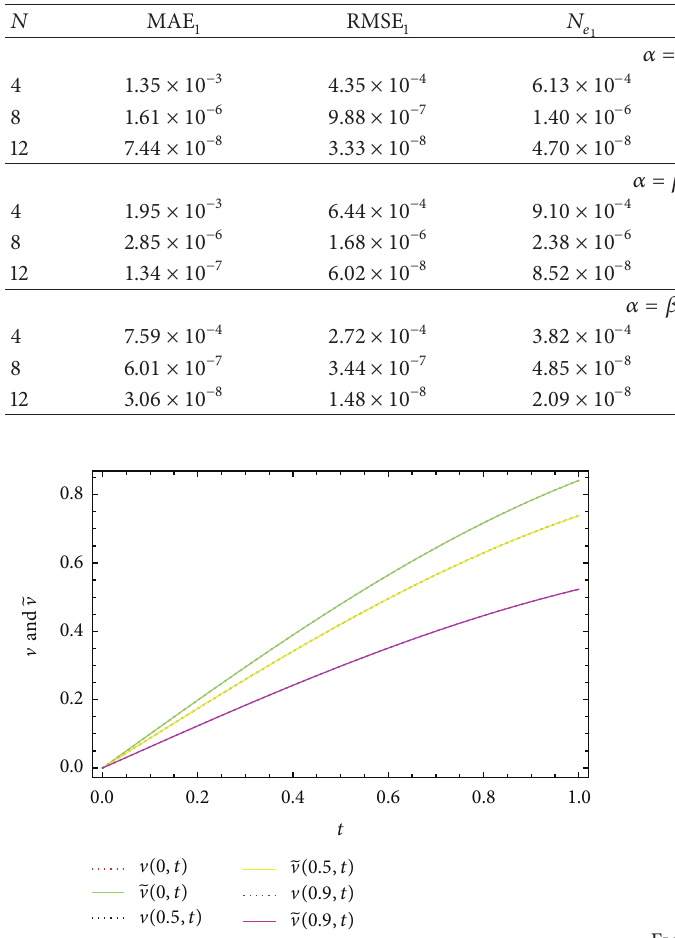
Figure 8: The absolute error 𝐸 2 of problem (51), where 𝑁 = 12 and 𝛼 = 𝛽 = −(1/2) in the interval [0, 1] .